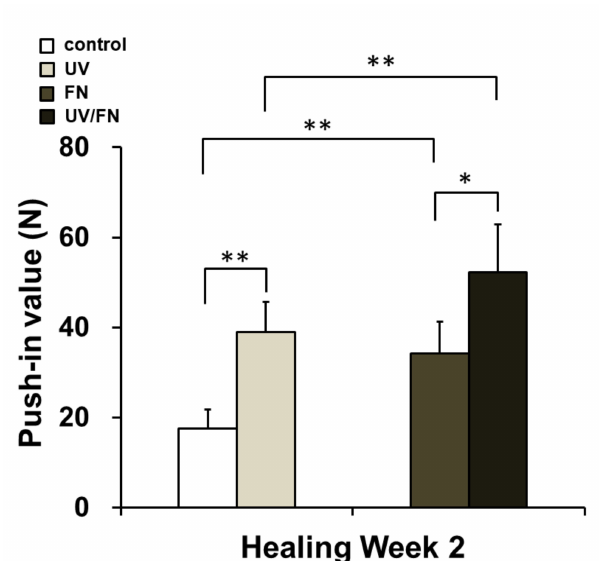
Figure 6. In vivo bone integration ability of di ff erently treated titanium implants. The biomechanical strength of bone-implant integration was evaluated using the biomechanical push-in test. Implants with control, UV-treated (UV), fibronectin-adsorbed (FN), and UV-treated and fibronectin-adsorbed (UV / FN) titanium surfaces were compared. A 1-h adsorption protocol was used in this experiment. Each bar represents the mean ± standard deviation of the control, UV, FN, and UV / FN implant groups (each n = 6; healing time: 2 weeks). * p < 0.05 and ** p < 0.01 represent significant di ff erences as determined by two-way ANOVA followed by Bonferroni